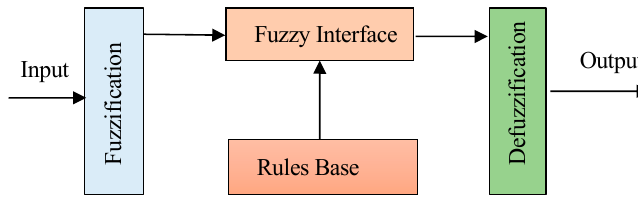
Figure 5. Basic structure of FLC.